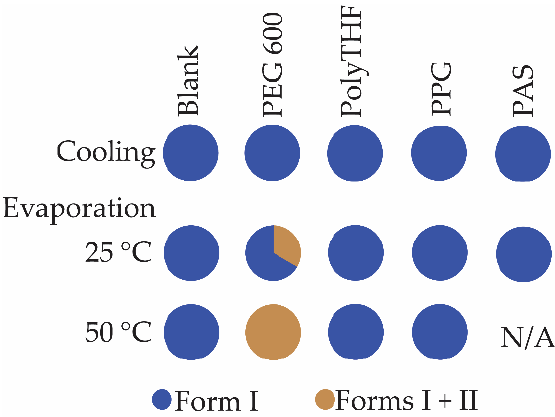
Figure 6. Polymorphic outcome in crystallization from toluene in the presence of viscous liquids as additives using different crystallization methods. Each third of the circle represents one of the parallel experiments. Abbreviations: PEG—polyethylene glycol; PolyTHF—poly tetrahydrofuran; PPG—polypropylene glycol; PAS—poly(acrylic acid).